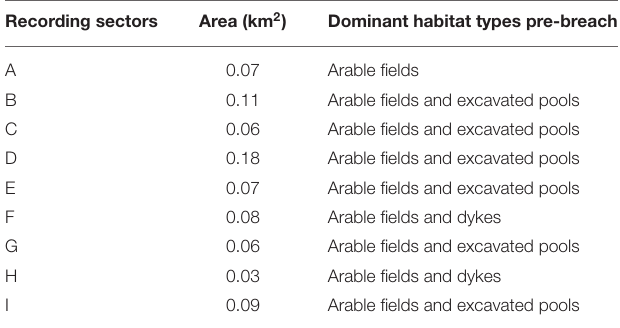
TABLE 1 | Size and dominant prior habitat creation of sectors within the Paull Holme Strays managed realignment (MR) site. Recording